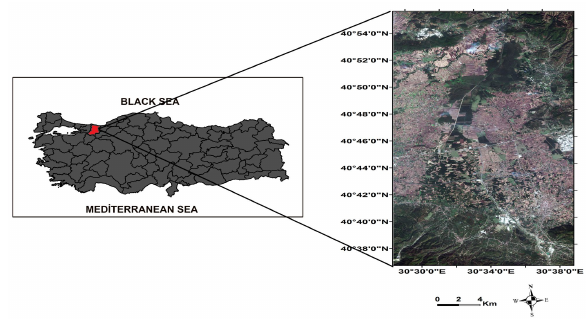
Figure 1: The location of the study site.